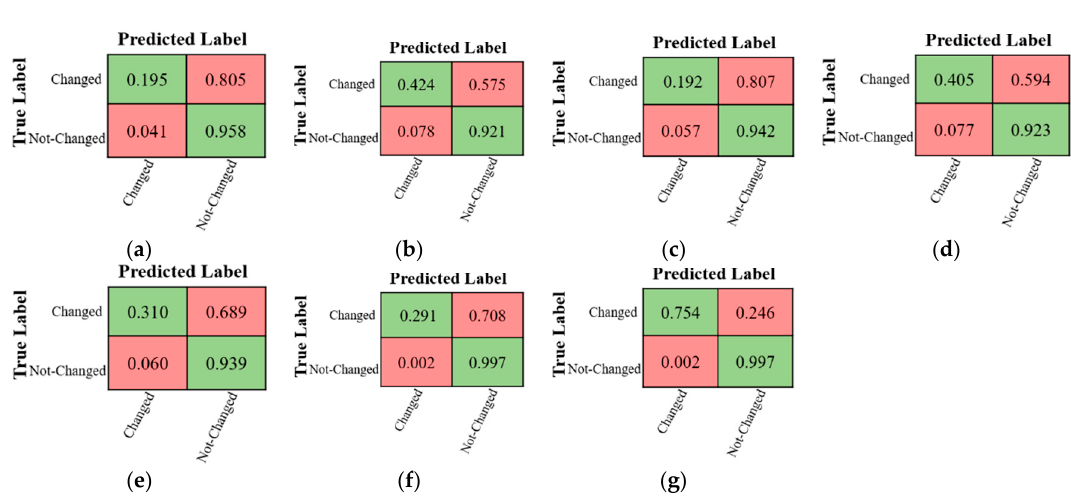
The visual comparison between the results of di ff erent CD methods for the Hyperspectral-River dataset is provided in Figure 15. The detection of changes within water bodies is generally di ffi cult due to the complexity of these regions. It was challenging for all CD methods investigated here to detect changes within the river and surrounding areas (center of the dataset). The main di ff erence in CD methods is related to the changes concentrated around the river. For example, there are many noisy pixels in the results of the CD by the IR-MAD and MAD algorithms. However, these areas are correctly identified using the proposed CD method (Figure